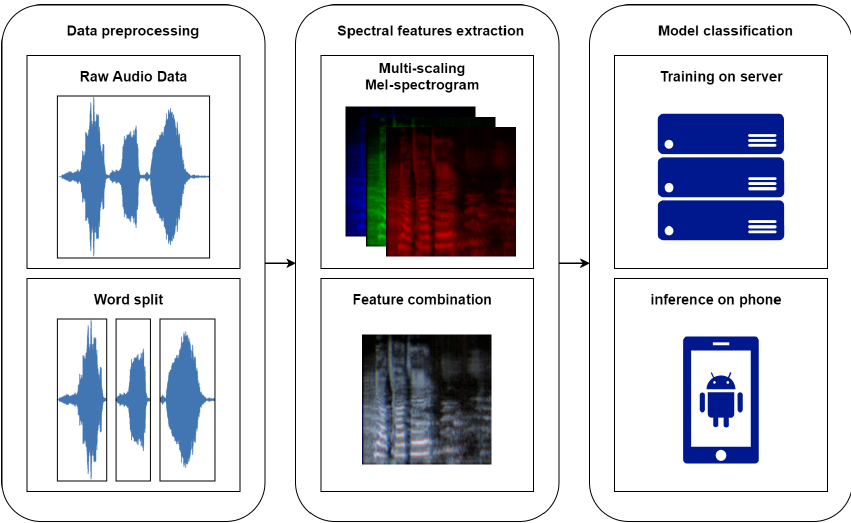
Figure 5. Overall workflow of the speech sound disorders